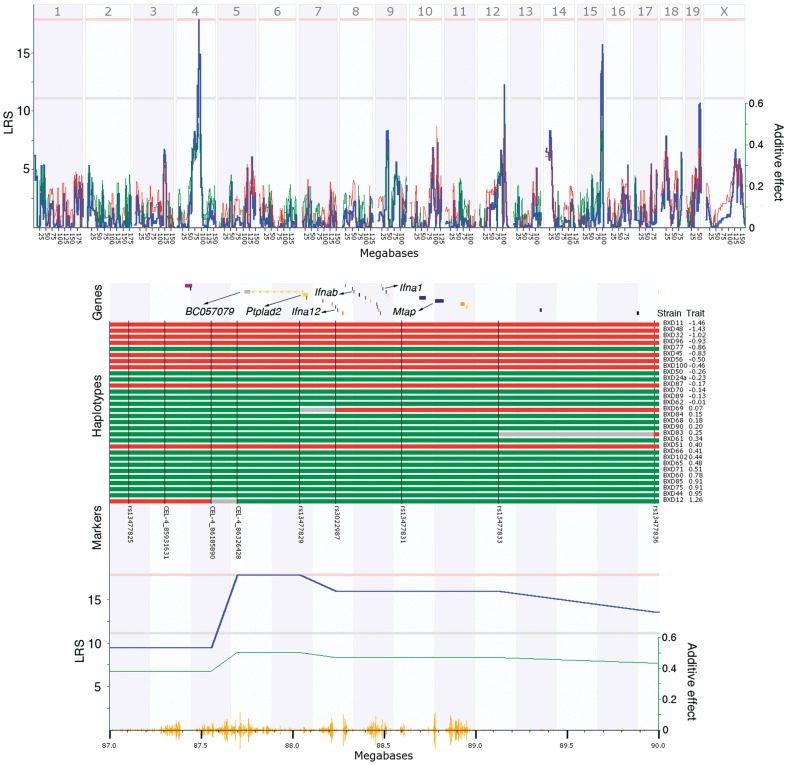
Genome-wide QTL mapping of Bacteroides composition in the gut of BXD strains.The Left y axis represents the strength of the linkage between Bacteroides composition to different DNA marker intervals on A) each chromosome (blue line) and B) detailed region of the QTL located on Chr 4 (LRS = 20.2, 82.12–95.05 Mb) that explains 27.5% of the composition in Bacteroides. The Right y axis represents the additive effect and indicates if the D (green line) or B (red line) allele contributes to an increase in the abundance of Bacteroides. Pink and gray horizontal lines indicates the significant (<0.05) and suggestive (<0.67) QTL threshold. b) B haplotype (red) is associated with a reduced level of Bacteroides while the D haplotype (green) is associated with an increased level of Bacteroides. Grey regions represent recombination spots. Yellow seismograph represents the SNP density between the sequence of the parental genomes. The QTL region is rich in genes from interferon family such as Ifna1, Ifna12 and Ifnab, all expressed in the cecum of BXD. Additional positional candidates include Ptplad2, BC057079 and Mtap.